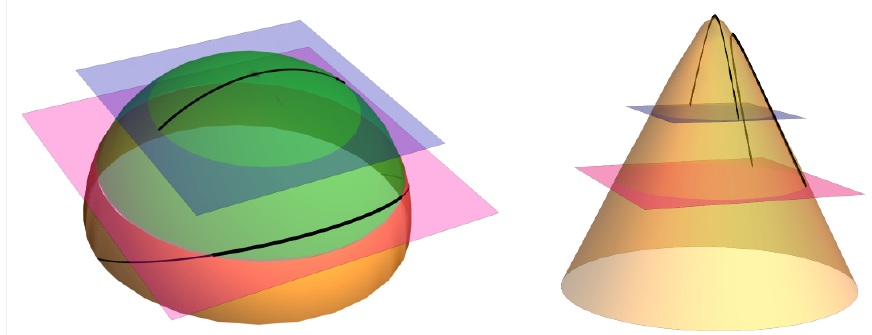
Figure 2 . Left: the entangling surface for r ? =L = (cid:25)= 3 | ( (cid:18); r ) are the polar and azimuthal angles, respectively, in the static patch of Euclidean dS 3 in presence of a cuto(cid:11) (cid:15) (magenta surface). The cuto(cid:11) surface restricts the entangling surface to the bolder line. We can rotate this surface by (cid:18) 0 = (cid:25)= 3 to bring it to the top of the sphere. If we draw a line through the ending points, we see that this corresponds exactly to a cuto(cid:11) surface with radius R e(cid:11) = R cos( (cid:12) (cid:15) ( r ? )), which is depicted in blue. By rotating the surface on the circle, we see that the entangling surface exactly corresponds to the half-circle, i.e. the interval consists of antipodal points. The (cid:12)eld theory lives on the circle on the magenta surface. Right: the analogous picture for Euclidean AdS 3 . Note that the transformation consists of a spacetime rotation and a special conformal